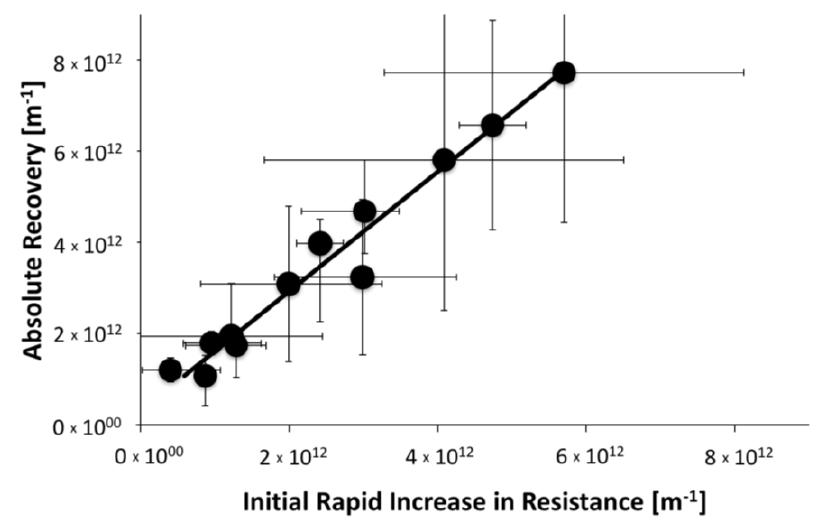
Figure 5. Correlation between Absolute Recovery and Initial Rapid Increase in Resistance (model raw waters containing SRNOM and a mixture of SRNOM + alginate; solid line: linear regression, R 2 = 0.97, slope = 1.31 ± 0.35, intercept = 3 × 10 11 ; p = 0.05; error bars correspond to minimum/maximum values).